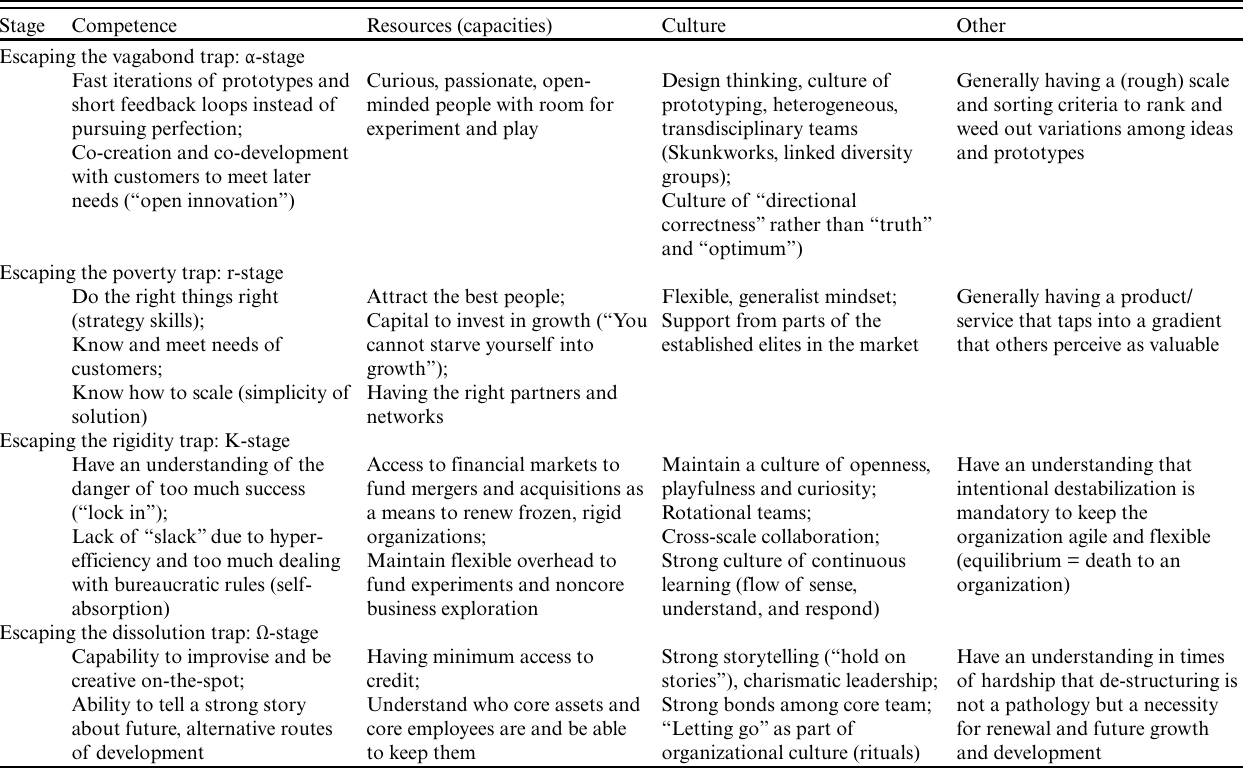
Table 4. Examples from business organizations of successfully navigating each phase.